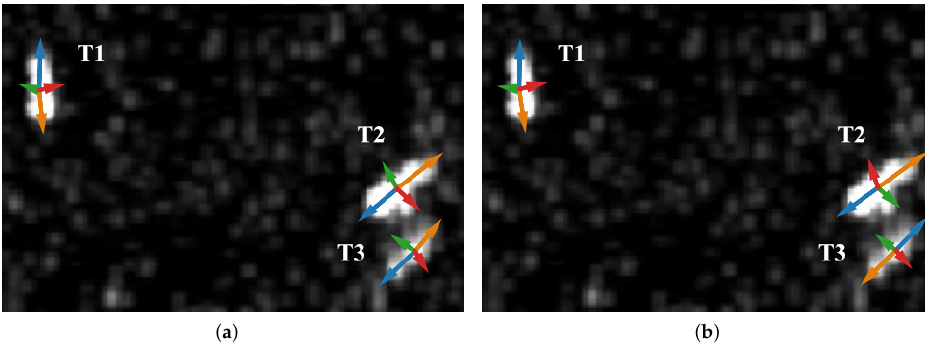
Figure 10. Illustration of shape descriptors trained by ( a ) fixed and ( b ) soft edge point assignment strategies. For clarity, only part of the test image is shown enlarged and the three targets are labeled as T1, T2 and T3.